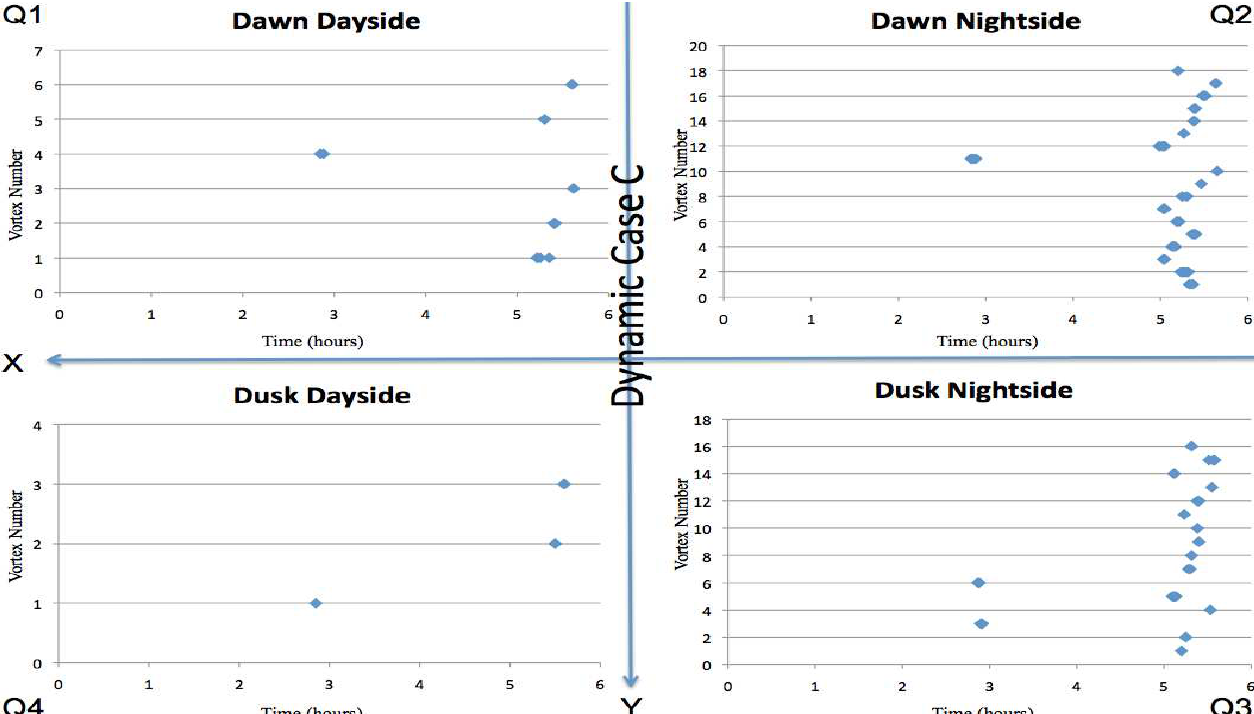
Fig. 15. Time duration of vortices for case C (dynamic cases) with a 10–15nT magnetic field magnitude. The vortices last only a few minutes before starting to dissipate. This figure only shows the duration of the vortices and not their rotation